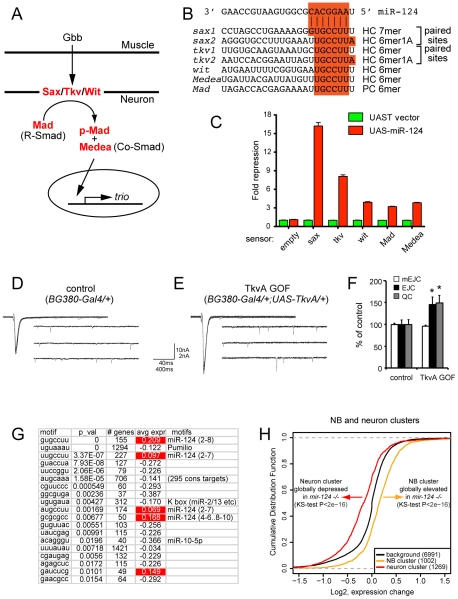
Functional interpretation of direct and indirect consequences of miR-124 loss.(A) Core components of the retrograde BMP signaling pathway at the NMJ. Release of the glass bottom boat (Gbb) ligand from the muscle activates BMP receptors (Sax, Tkv and Wit) in the neuron. Activated BMP receptors induce phosphorylation of Mad, which partners with Medea to activate target genes, such as trio. (B) miR-124 binding sites; HC = highly conserved and PC = poorly conserved (see also Figure S8). (C) Sensor assays in S2 cells confirm that the 3′ UTRs of all five BMP pathway components are responsive to miR-124. (D–F) Ectopic activation of Tkv receptor can phenocopy mir-124 mutant electrophysiology. Representative traces of evoked (excitatory junction currents, EJC) and spontaneous (miniature EJC, mEJC) membrane currents recorded from muscle 6 in the third abdominal segment in w[1118]; BG380-Gal4/+ (D) and w[1118]; BG380-Gal4/+; UAS-TkvA/+ (E) wandering third-instar larvae. EJC contain 10 consecutive superimposed traces and mEJC are three traces of continuous recordings. (F) Quantification of mEJC, EJC, and quantal content (QC) for the indicated genotypes. Activated Tkv did not affect spontaneous activity, but caused significant increases in evoked currents and quantal content. n = 12 NMJs for each genotype. Error bars represent SEM, statistical tests by two-tailed t-test show *p<0.05. (G) miREDUCE analysis shows that variations of the miR-124 seed are strongly enriched amongst transcripts that increase in mir-124 mutant cells (highlighted in red). Amongst motifs associated with decreased gene expression in mir-124 mutants, the top motif corresponds to the Pumilio site; others motifs include the seeds of K box family miRNAs, miR-10-5p, and an orphan motif (AUGCAAA) with several hundred conserved matches (defined by TargetScan). (H) Cumulative distribution function (CDF) plots of gene in the neuron and NB clusters. The group of neural genes is shifted towards lower expression levels in the mir-124 mutant, while the NB cluster is shifted towards higher expression.